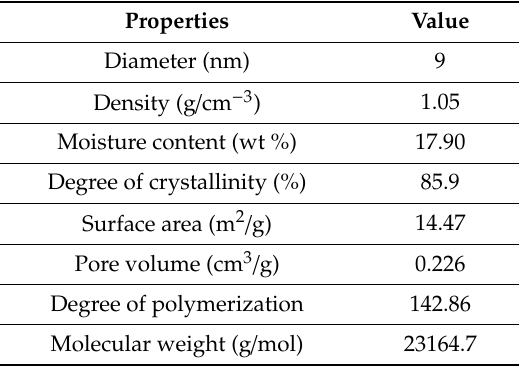
Table 2. Physical properties of sugar palm